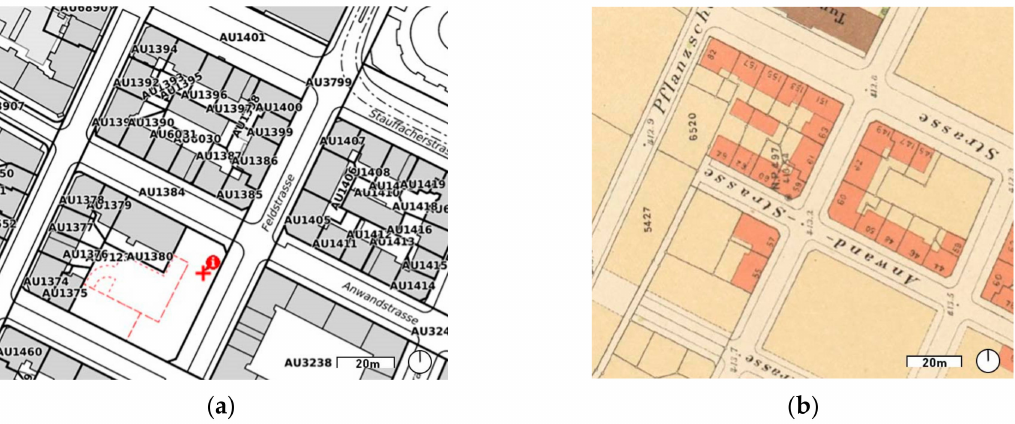
Figure 2. Plot division over time in Zurich Wiedikon: ( a ) cadastral map of the building block 2022 [10]; ( b ) cadastral map of the building block 1900 [10].